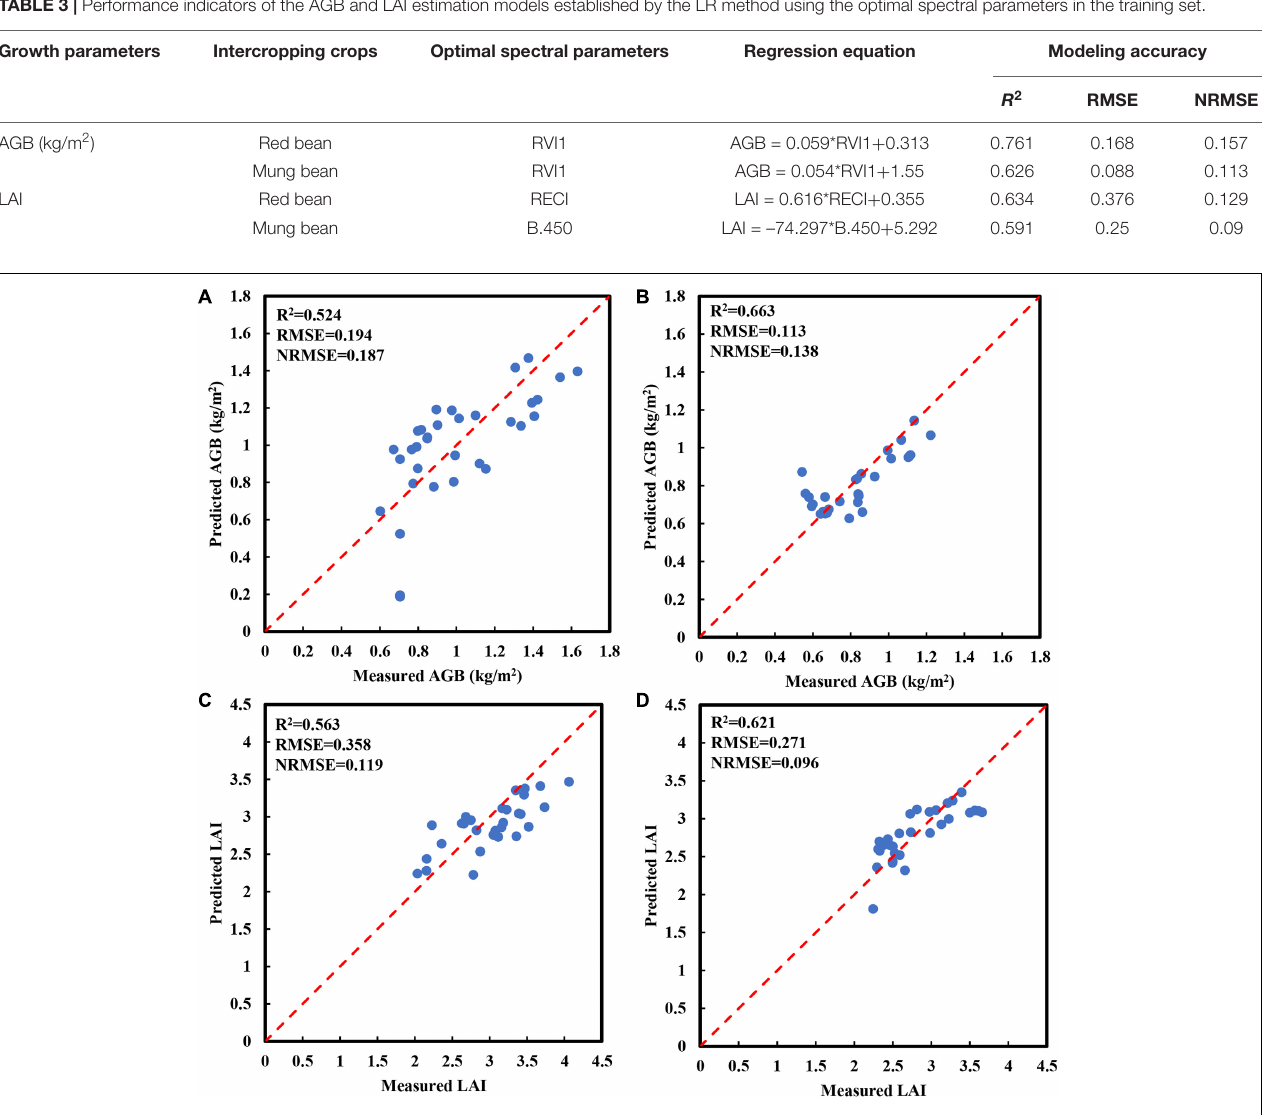
FIGURE 4 | Relationship between the predicted and measured AGB and LAI obtained by using linear regression (LR) methods using the optimal spectral parameters in the test set. (A) AGB of red bean; (B) AGB of mung bean; (C) LAI of red bean; (D) LAI of mung bean. The red line is a 1:1 line. TABLE 4 | Performance indicators of AGB and LAI estimation models established by the SMLR methods in the training set. Growth